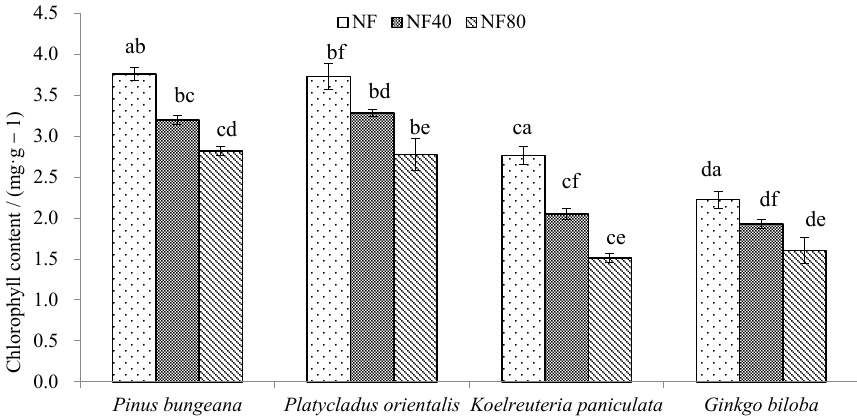
Figure 3. Effect of increasing ozone concentration on chlorophyll content of trees. Different letters indicate that there are significant differences between different ozone treatments ( p < 0.05).